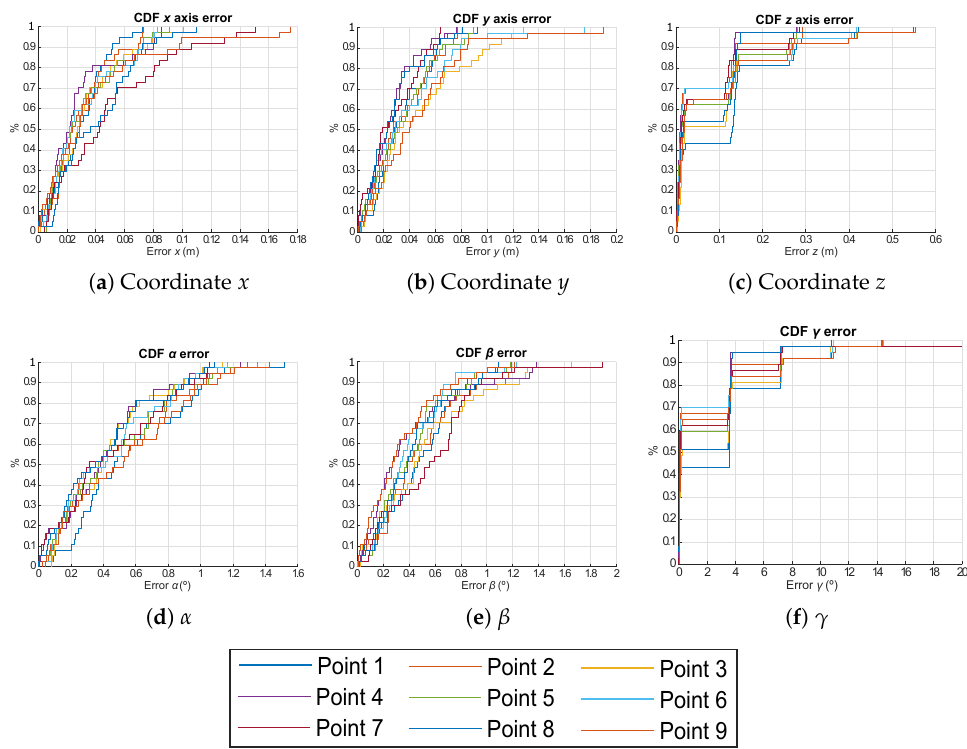
Figure 7. CDF of the absolute pose errors for the nine representative points defined in Table 1 for the case of using the EPnP